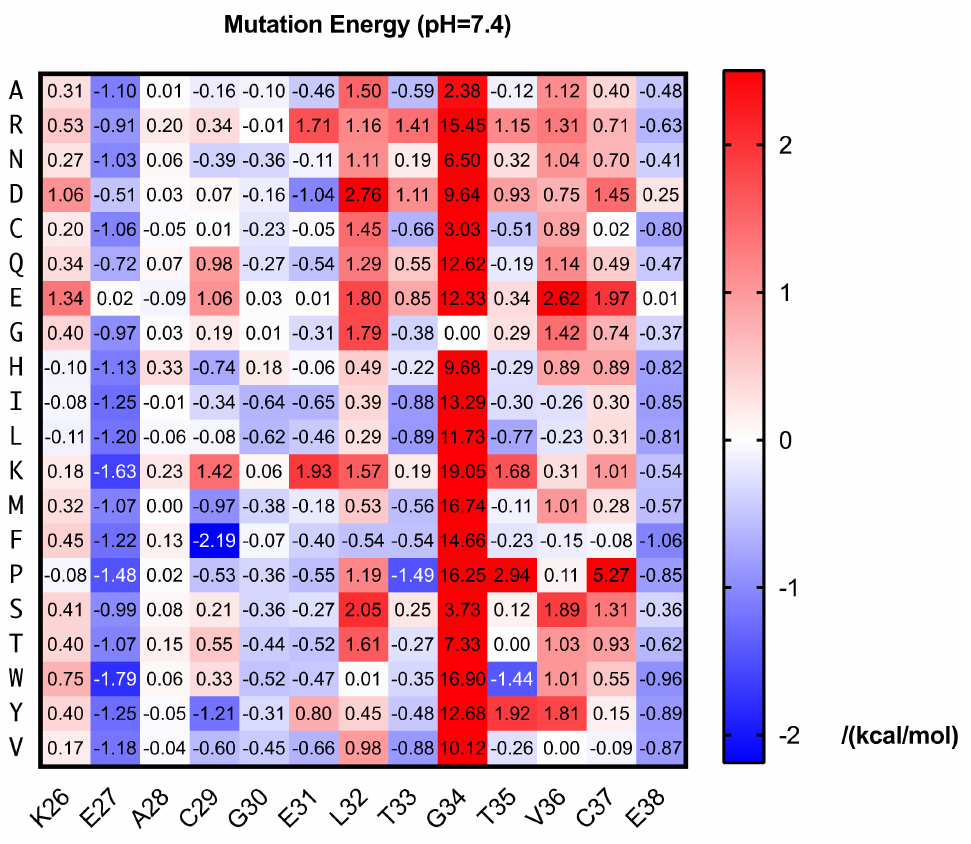
Figure 1. Predicted mutation energy of BTLA-HVEM (26–38) binding at pH